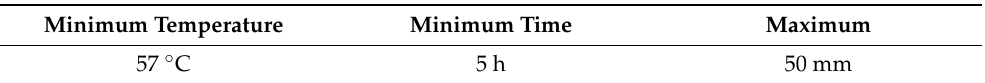
Table 2. Conditions to produce a sanitized digestate when using animal by-products (e.g., manure and slurry) as feedstock in AD